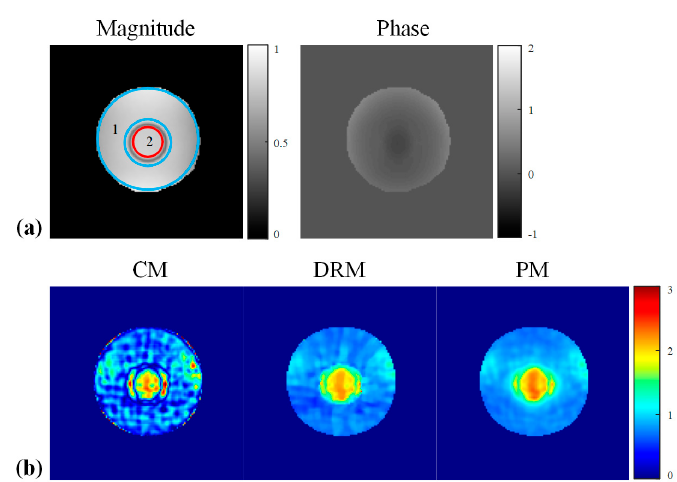
Figure 9. Phantom reconstruction result. ( a ) Magnitude and phase images of the phantom; the SNR of the magnitude image is 132. ( b ) The reconstructed conductivity images using the conventional method (CM), double regularization method (DRM), and the proposed method (PM). Table 2. Reconstructed conductivity values of phantom experiment. Measured Conventional Method Double Regularizations Method Proposed Method